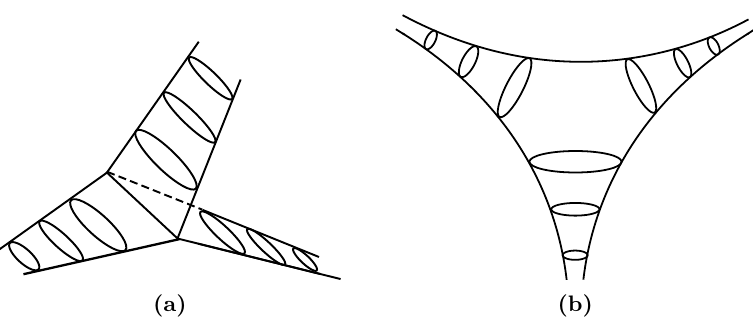
Figure 1. The two classes of Feynman diagrams relevant for the fermion six-point function.